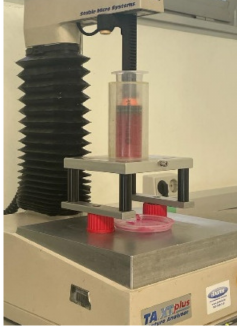
Figure 1. Extrusion test setup.